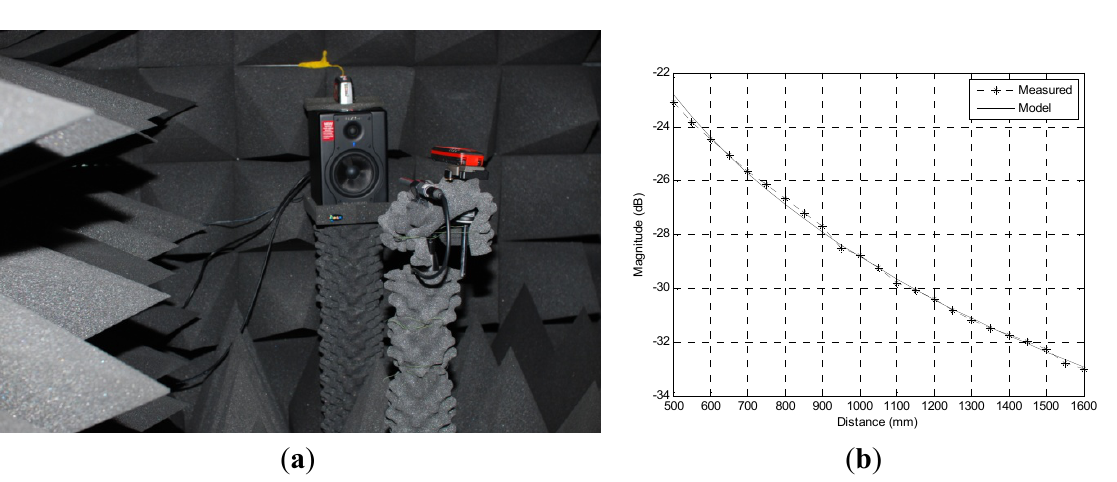
Figure 11. ( a ) Experiment and ( b ) distribution of sound pressure level in the anechoic